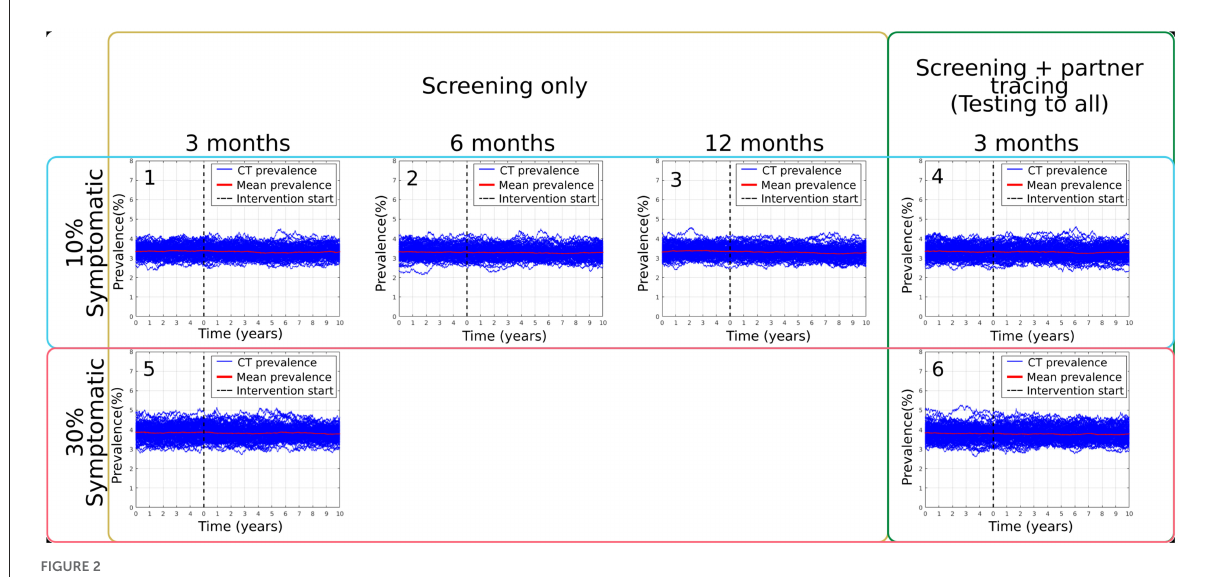
FIGURE2 Summary of main results obtained from targeted: follow-up screening simulations, varying follow-up waiting periods, scenarios Bi (1) , Bii (2) , Biii (3) , the modeled percentage of symptomatic population present in the model, as well as the addition of one version of partner tracing on scenarios Biv (4) , Ci (5) and Cii (6)